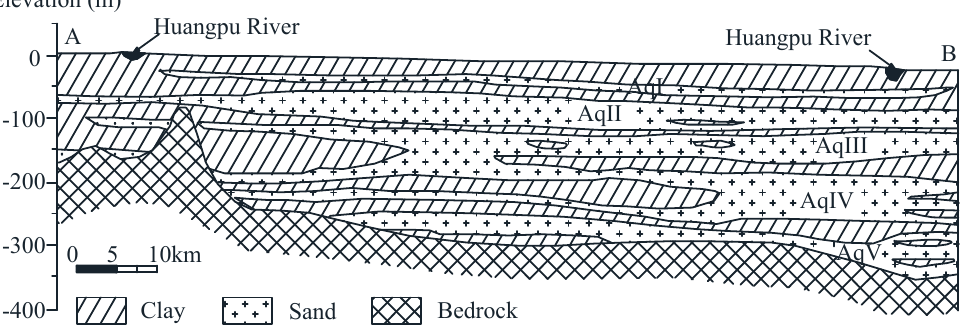
Figure 2. Geology and hydrogeology profile of Shanghai (cross-section A–B in Figure 1) (data from Reference [28]).